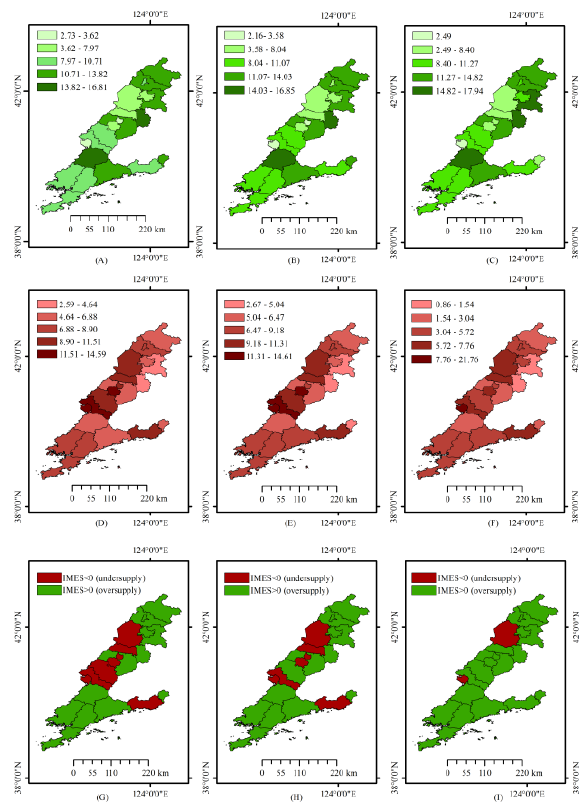
Figure 2. Ecosystem services supply(A:2005,B:2010,C:2015), demand(D:2005,E:2010,F:2015) and balance(G:2005,H:2010,I:2015) in the central and